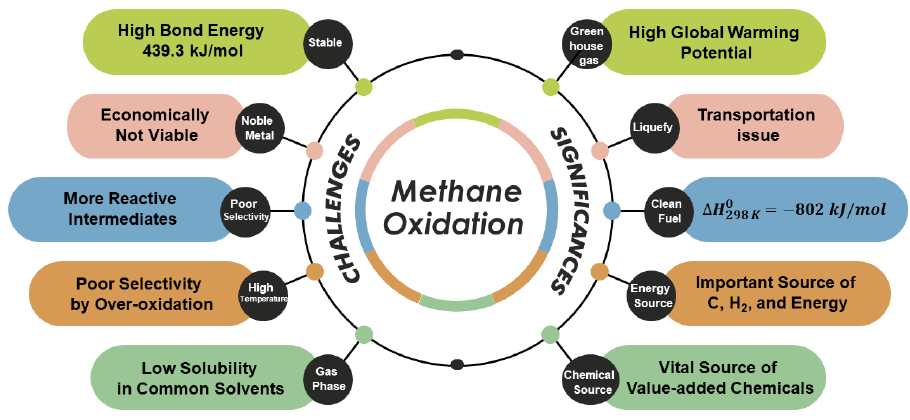
Figure 2. Challenges in and significance of CH 4 oxidation.